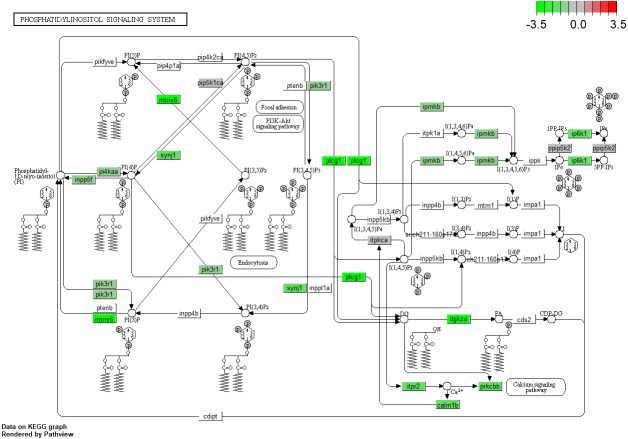
Phosphatidyl Inositol Signaling.Kyoto Encyclopedia of Genes and Genomes (KEGG) pathway enrichment (P < 0.05) representing phosphatidylinositol signaling from lepa rescue compared to control microarrays. Color scale reflects log2 fold change for differentially expressed genes.